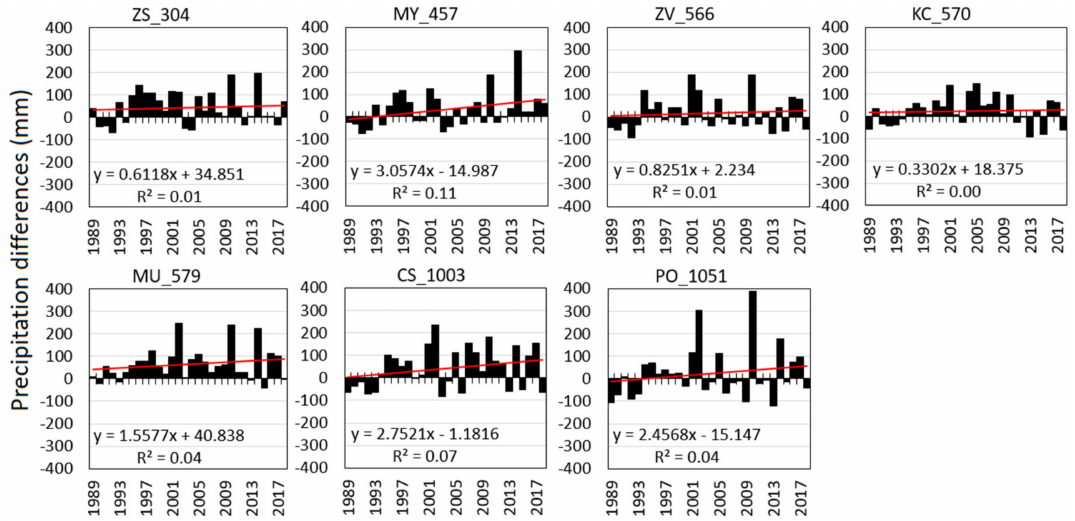
Figure 2. Di ff erence of precipitation during summer seasons in 1989–2018 (P VII–IX ) compared to the normal of 1961–1990 (PN VII–IX ): the black bars show the precipitation di ff erence in mm. The red line trends indicate the linear relations including their numerical representation. Table 6. Di ff erences of the summer precipitation total (P VII–IX ) from the precipitation normal of summer with bold, t ( α ;f − 1) is the critical value, and t is the test statistics. Stand t ( α ;f − 1) t p ZS_304